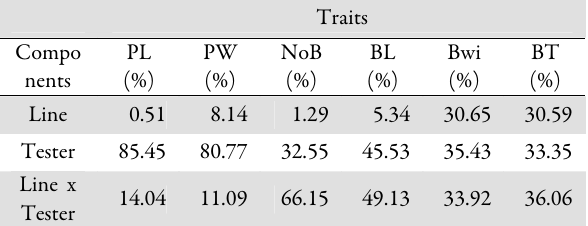
Tab. 4. Proportion of contribution to the variance